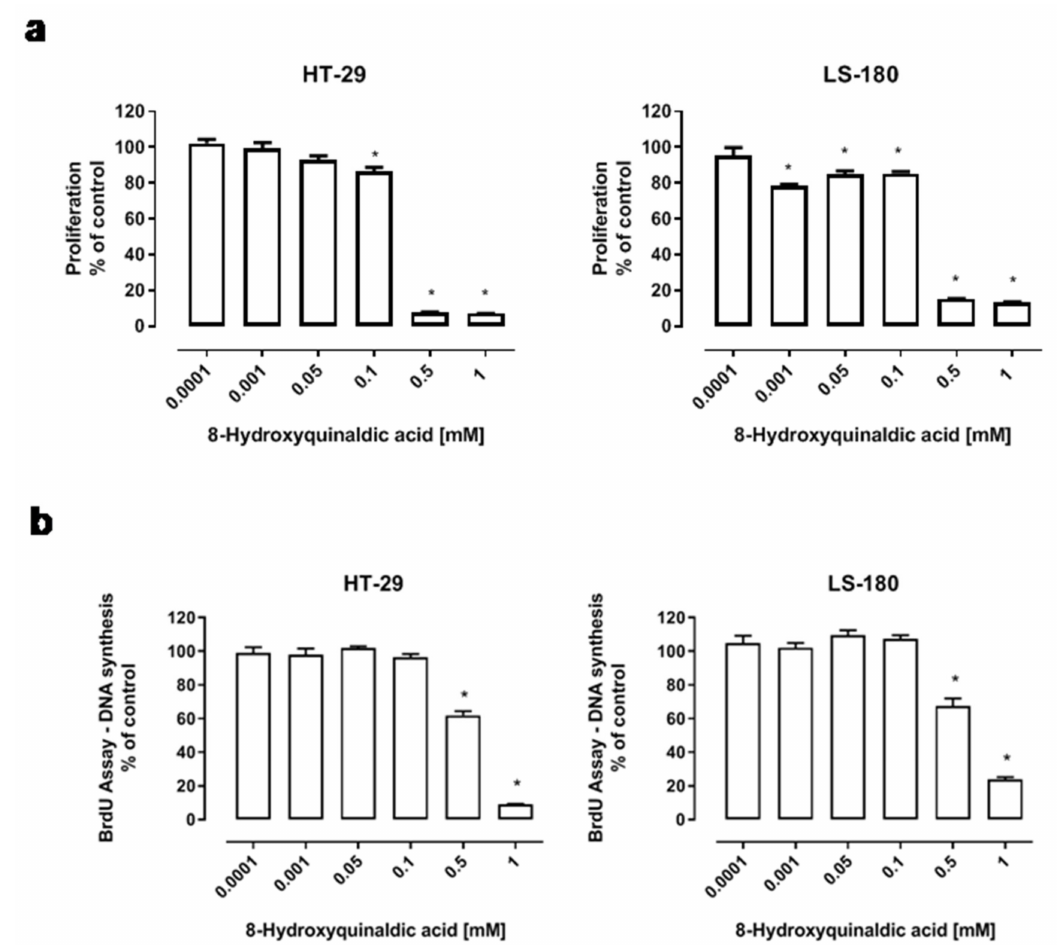
Figure 3. The e ff ect of 8-hydroxyquinaldic acid on proliferation ( a ) and DNA synthesis ( b ) of human colon adenocarcinoma cells. HT-29 and LS-180 cells were exposed to culture medium (control) or serial dilutions of 8-hydroxyquinaldic acid (0.0001; 0.001; 0.05; 0.1; 0.5; 1 mM) in culture medium. The e ff ect of tested compound on proliferation and metabolic activity of HT-29 and LS-180 cells was assessed by MTT assay after 96 h of incubation ( a ). The e ff ect of 8-hydroxyquinaldic acid on DNA synthesis of HT-29 and LS-180 cells was assessed by BrdUassay after 48 h of incubation ( b ). Mean percentage values (% of control) ± SEM of six independent experiments (the mean value of control = 100%) are presented. Values were reported as statistically significant in comparison to the control at * p < 0.05 (one-way ANOVA with Tukey post hoc